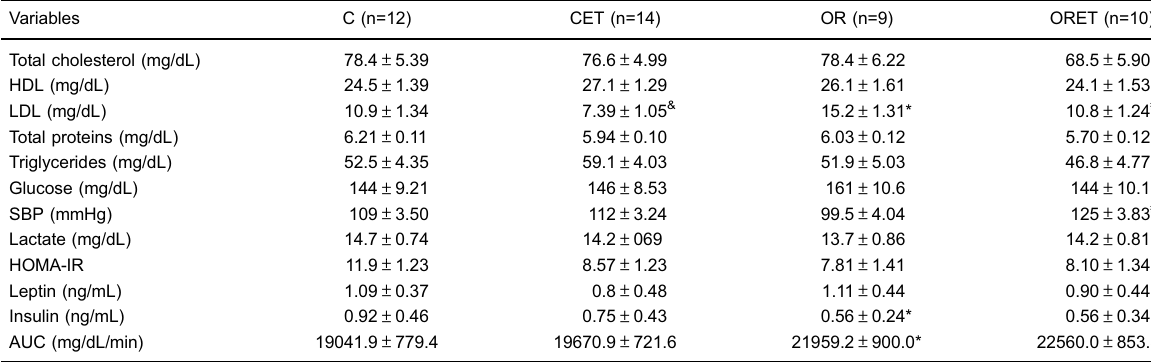
Table 3. Biochemical, hormonal, glycemic, and hemodynamic pro fi les.